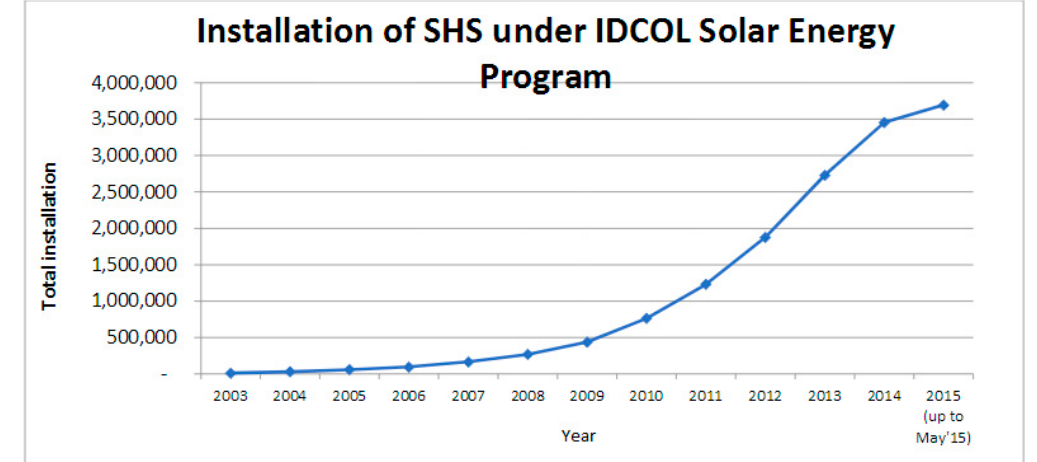
Figure 2. Annual SHS installations in Bangladesh [16].